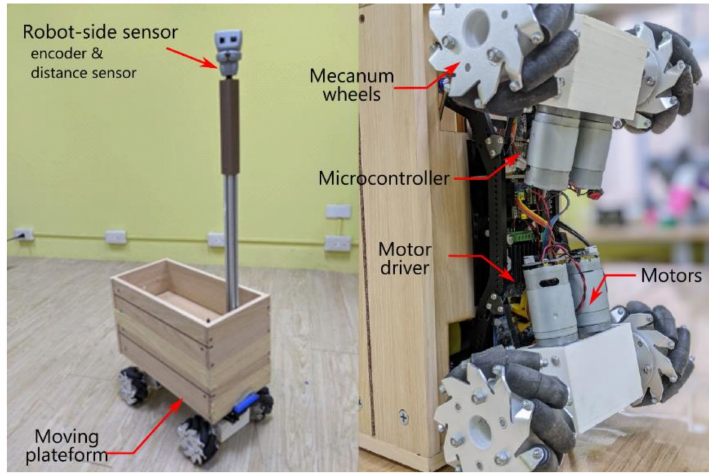
Figure 5. Assembly of the tested accompanying